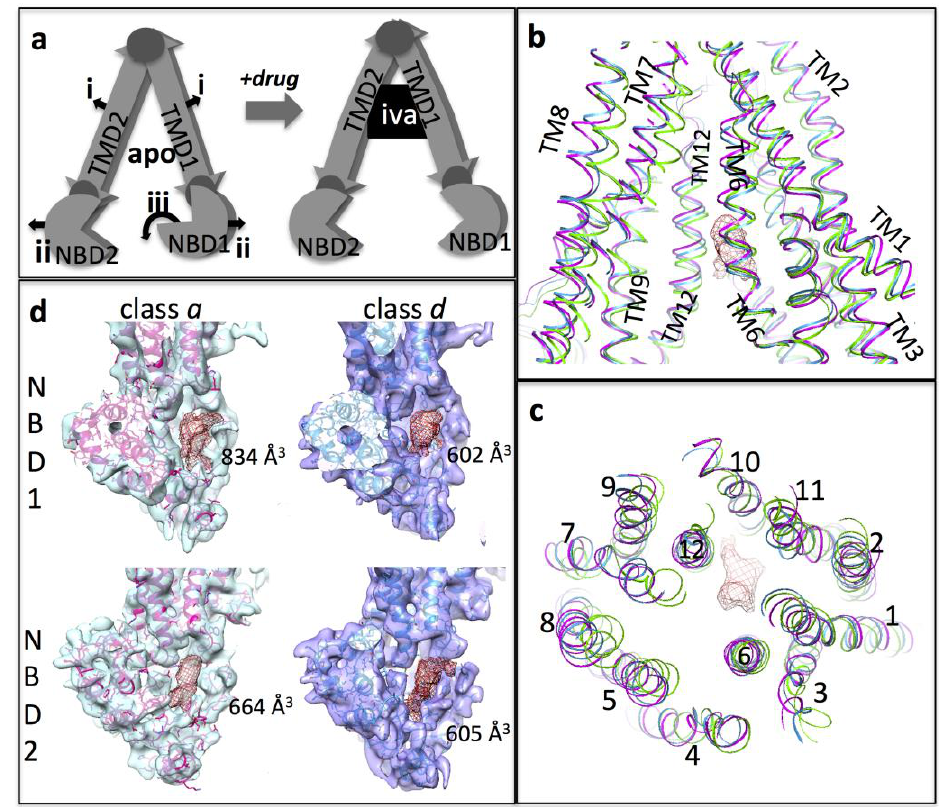
Figure 3. Allostery: ( a ) Cartoon representation of conformational changes discussed with regard to the presence of ivacaftor with P-gp. Left shows the assumed apo-state and indicates the movements of the TMDs and NBDs associated with the drug-bound state (right): (i) the TMD helices bow outwards and the central cavity enlarges. (ii) The NBDs become more separated. (iii) NBD1 rotates downwards. The small darker circles indicate hinge points between domains. ( b , c ) outward bulge of the TMDs in the atomic model from map a (pink ribbon) vs. models from map e (green) and map d (blue). The additional density associated with ivacaftor in map a is shown (red mesh). Panel b is a section viewed along the membrane plane; panel c is a section viewed from the extracellular surface. ( d ) NBD1 and NBD2 in experimental maps a and d viewed from between the NBDs (blue and purple semi-transparent surfaces). The real-space refined atomic models for P-gp fitted to the maps are in red and blue, respectively. The nucleotide-binding cavity is indicated with the red mesh and its volume is given in cubic